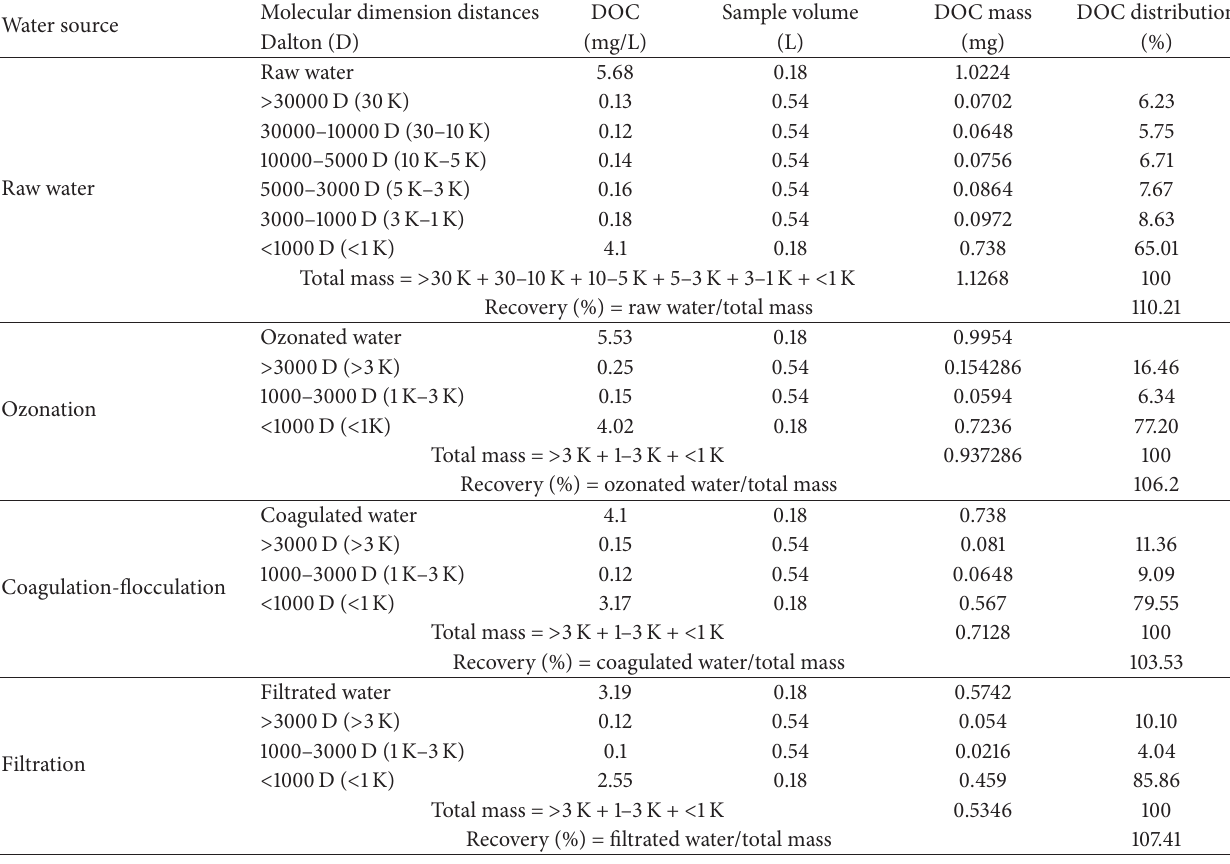
Table 2: DOC mass balance and recovery for each water treatment